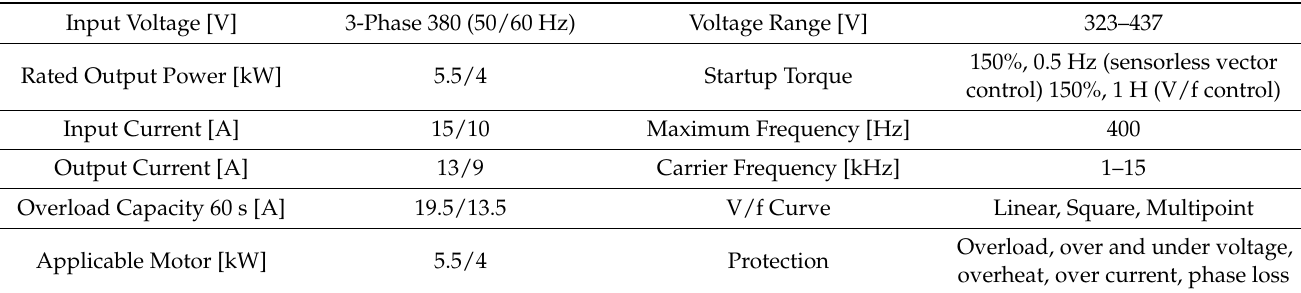
Table 1. Technical specification of the frequency converter